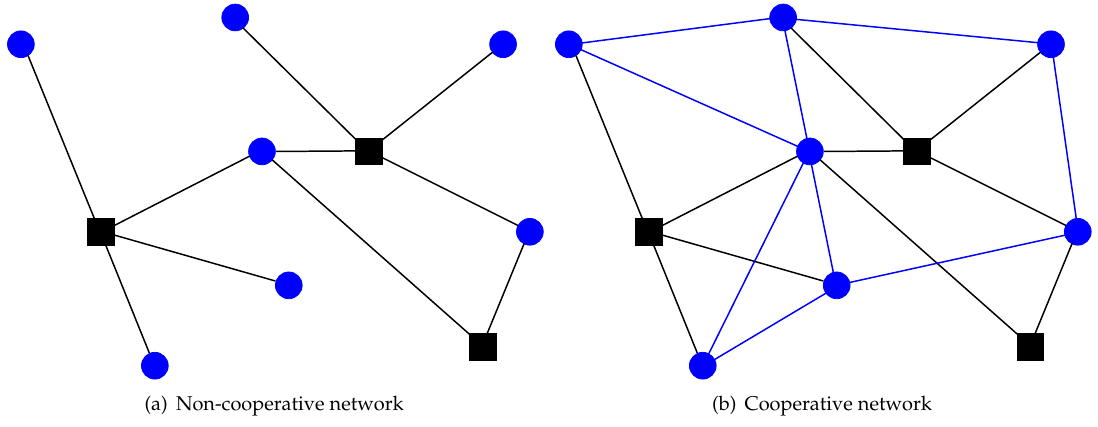
Figure 2. Illustration of different network types based on the type of